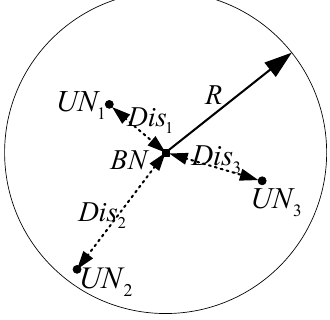
Figure 2. Distance relationship of sensor nodes.